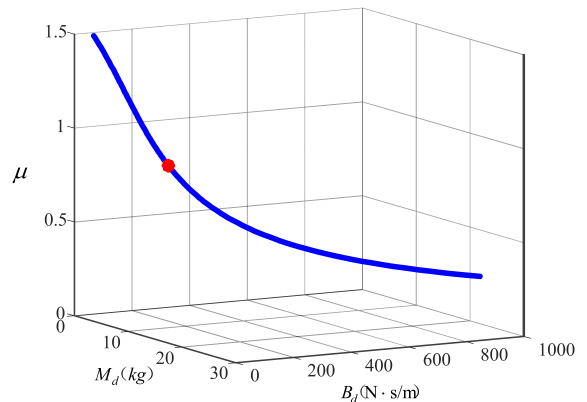
Figure 6. All the parameters satisfying the pre-specified gain crossover frequency and phase